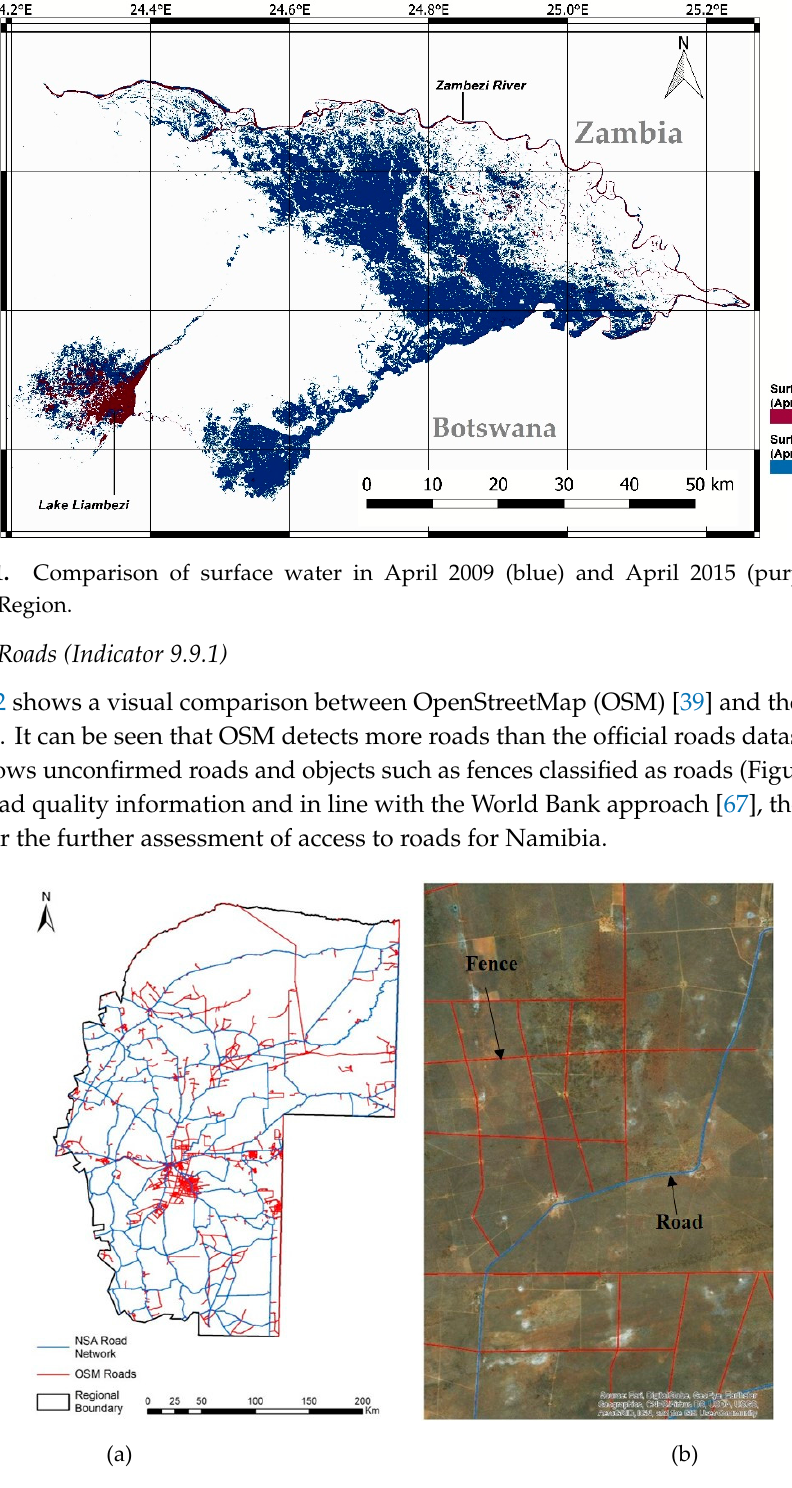
Table 6. Total Population estimates for Omaheke.